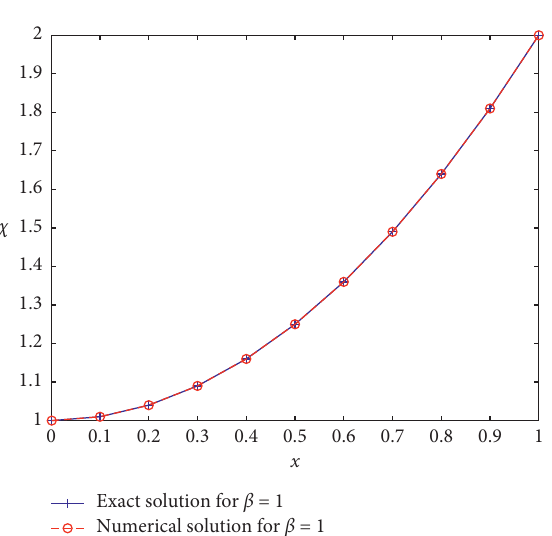
Figure 6: The numerical and exact solutions for fractional order β �